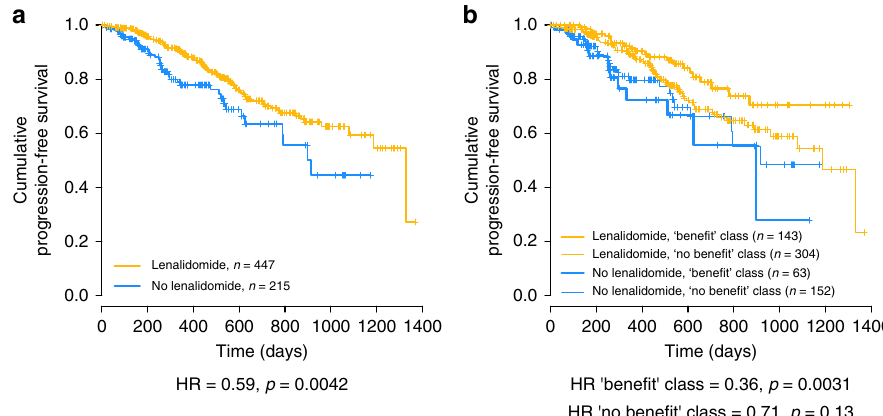
and STL obtains classi fi ers that successfully predict bene fi t in all folds. Since the CoMMpass dataset is smaller than the bortezomib dataset used before, we required the “ bene fi t ” class to contain at least 30% of the patients, to ensure suf fi cient power. This results in a combined HR of 0.36 (95% CI: 0.18 – 0.71, p = 0.0031, n = 206) over the entire dataset, as shown in Fig. 3b. In total 31.1% of patients were classi fi ed as class “ bene fi t ” . Again, the STL classi fi er was able to distinguish a subset of patients with signi fi cant treatment bene fi t in each fold with HRs of 0.27 (95% CI: